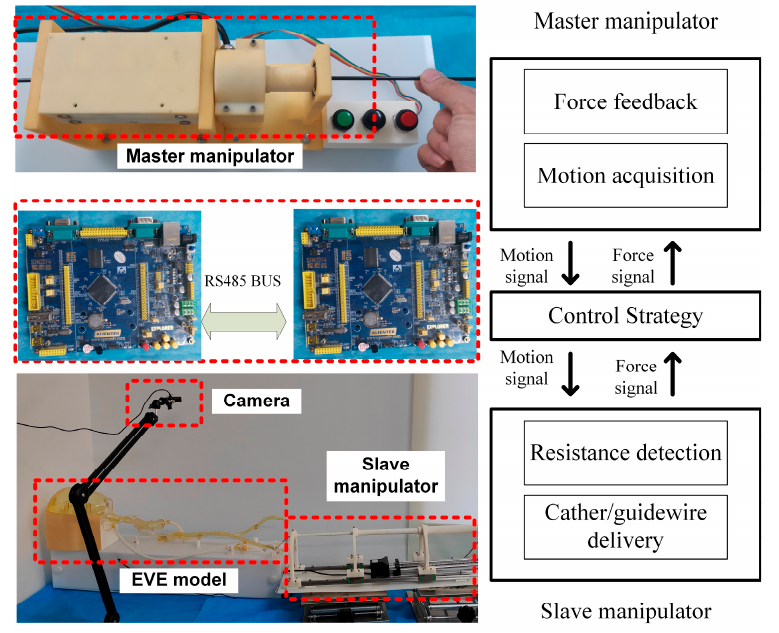
Figure 17. Experimental environment setup.